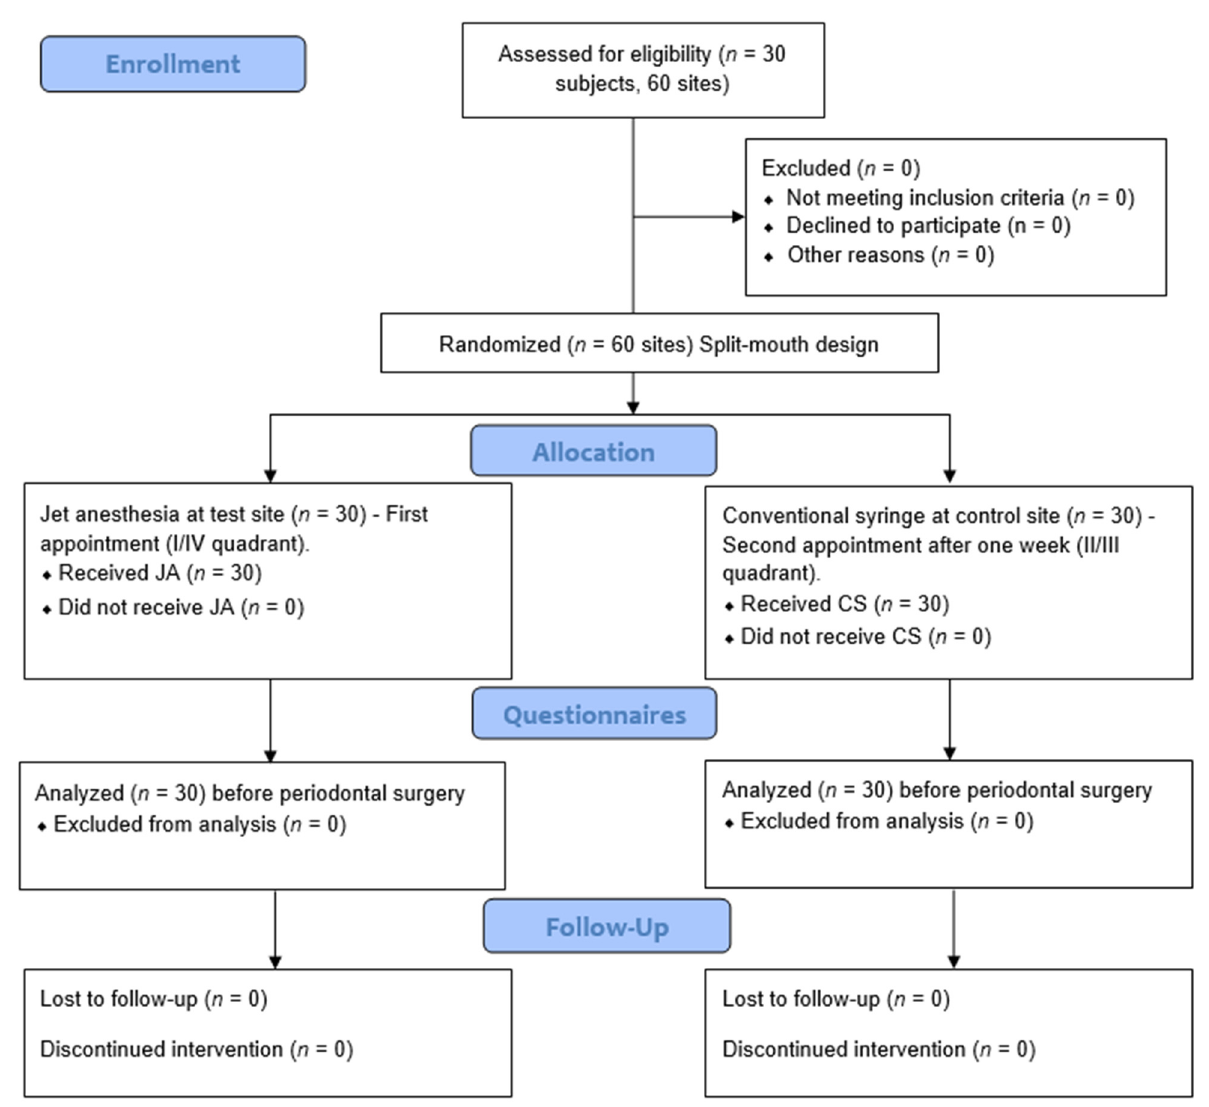
Figure 3. Flowchart of study design.